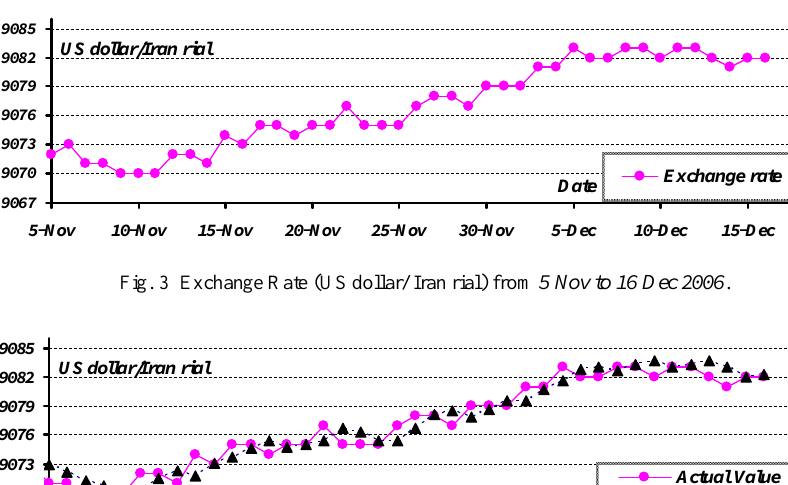
Note : The upper and lower bounds values are rounded.